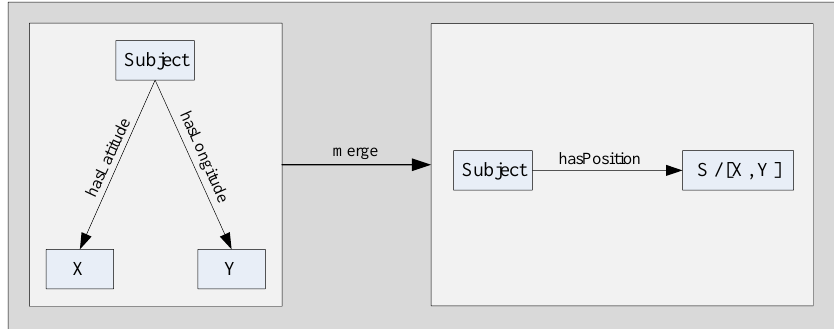
Figure 3. Representation model of spatial entities.